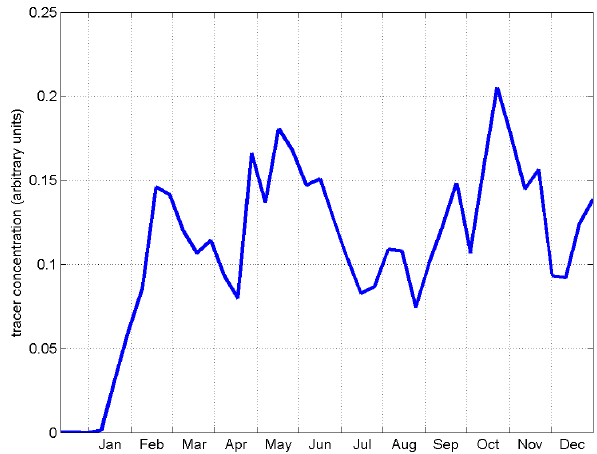
Fig. 7. Time series of passive tracer concentration at the OCCAM location of the overflow at the moorings, taken from grid cell at location marked “X” in Fig. 2c. Passive tracer was initialised at the sill on grid cells with 27 . 6 < σ θ < 27 . 8, on 12 December 2003, and continuously released until 31 December 2004. This water mass constitutes around 10-15% of the water present at location ‘X’.